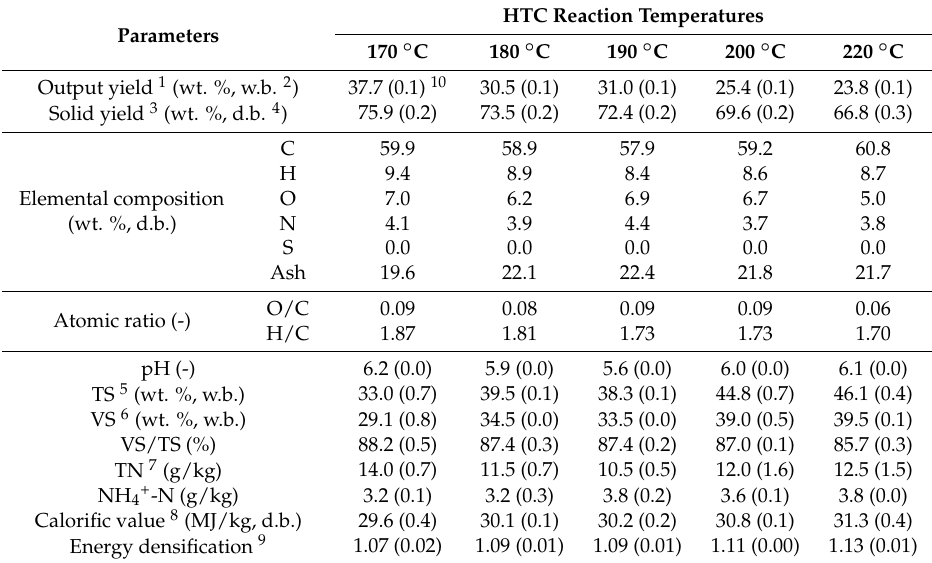
Table 3. Physicochemical properties of HTC-biochar produced at different HTC reaction temperatures.